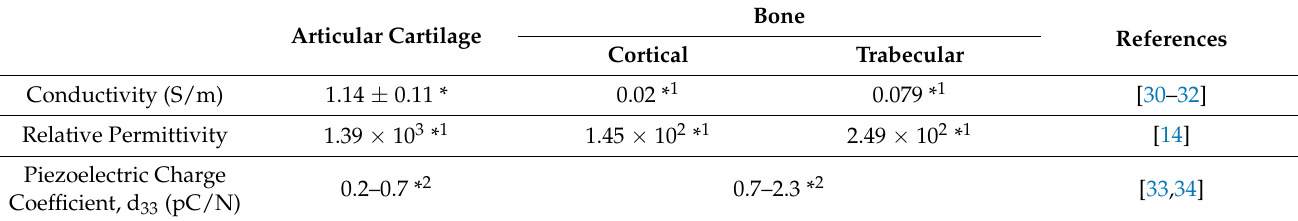
Table 1. Summary of main dielectric and piezoelectric properties of articular cartilage and cortical and trabecular bone. It should be noted that the values were obtained from different animal models: bovine (*), porcine (* 1 ), and human (* 2 ). Even though research on the topic is scarce, it is important to consider that the piezoelectric properties of bone and cartilage are likely affected by aging and tissue degeneration, given the effects of these factors on the tissues’ ECM composition (collagen degradation) and mechanical properties that have already been reported in the literature